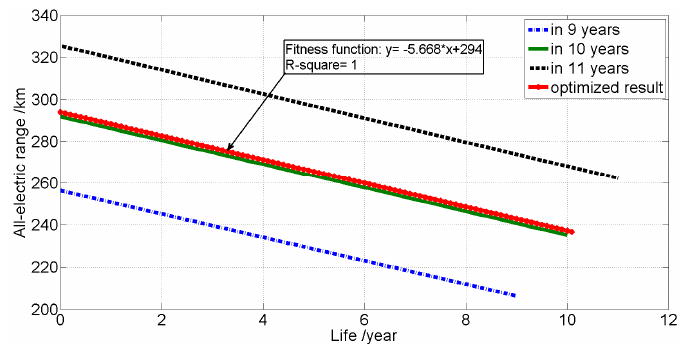
Figure 11. The varying all-electric range with increasing operation lifetime.